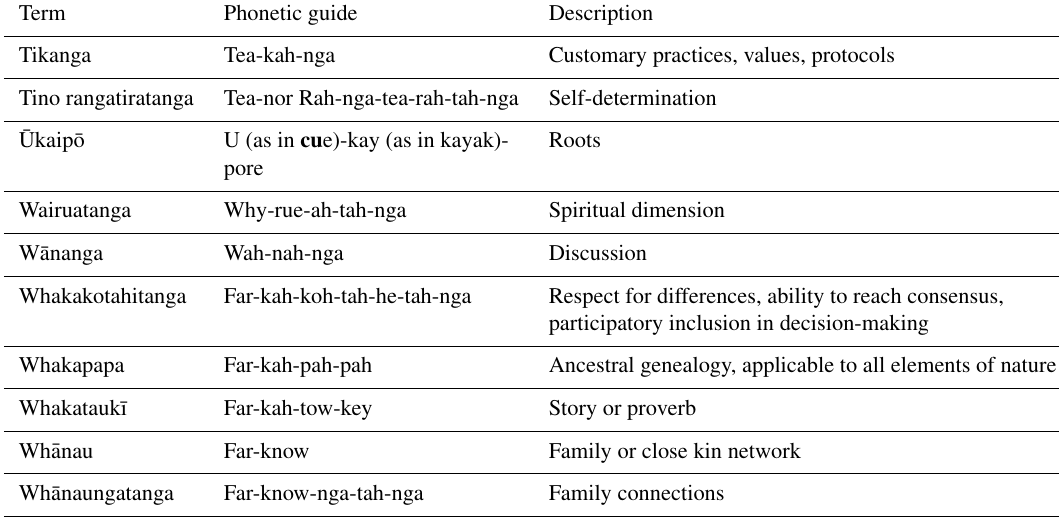
Table 2. Glossary of English terms (as used in this paper). Cultural